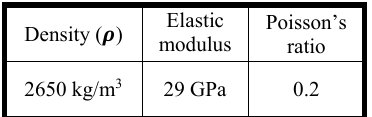
Table 1. Particle material properties used in DEM model.